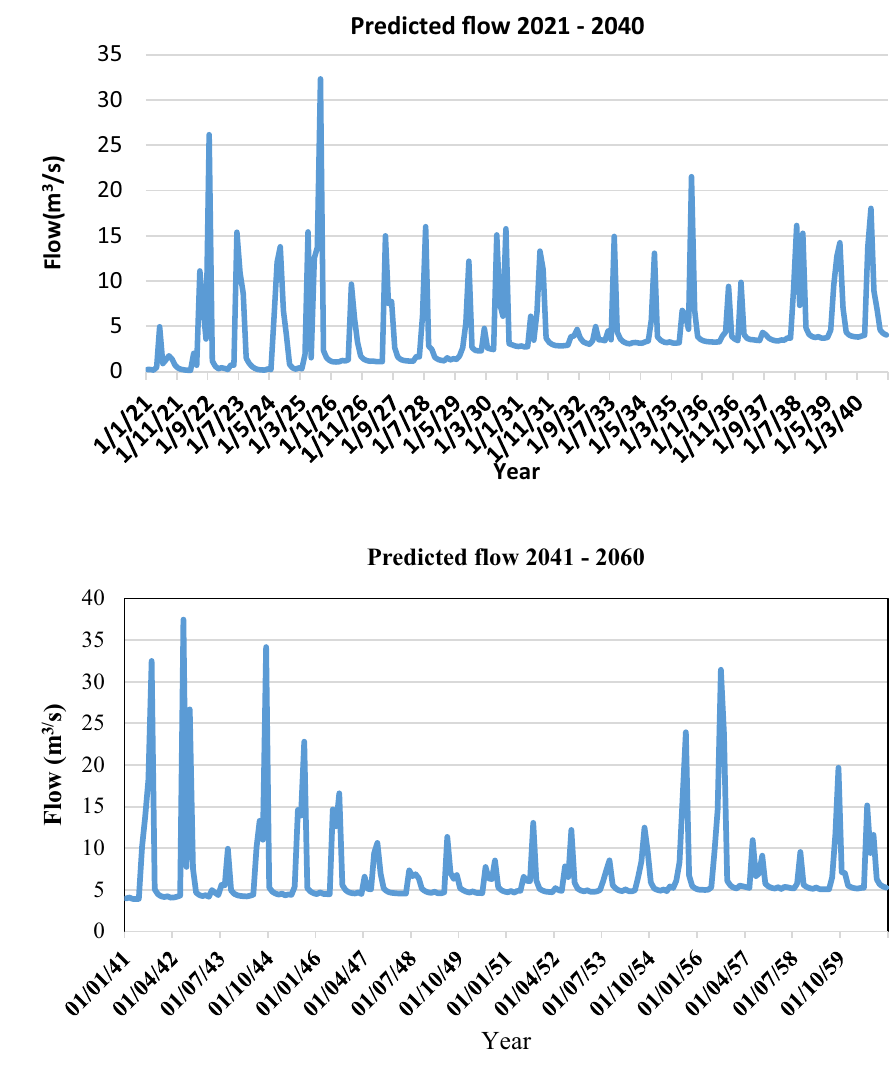
Fig. 6 Future predicted flow